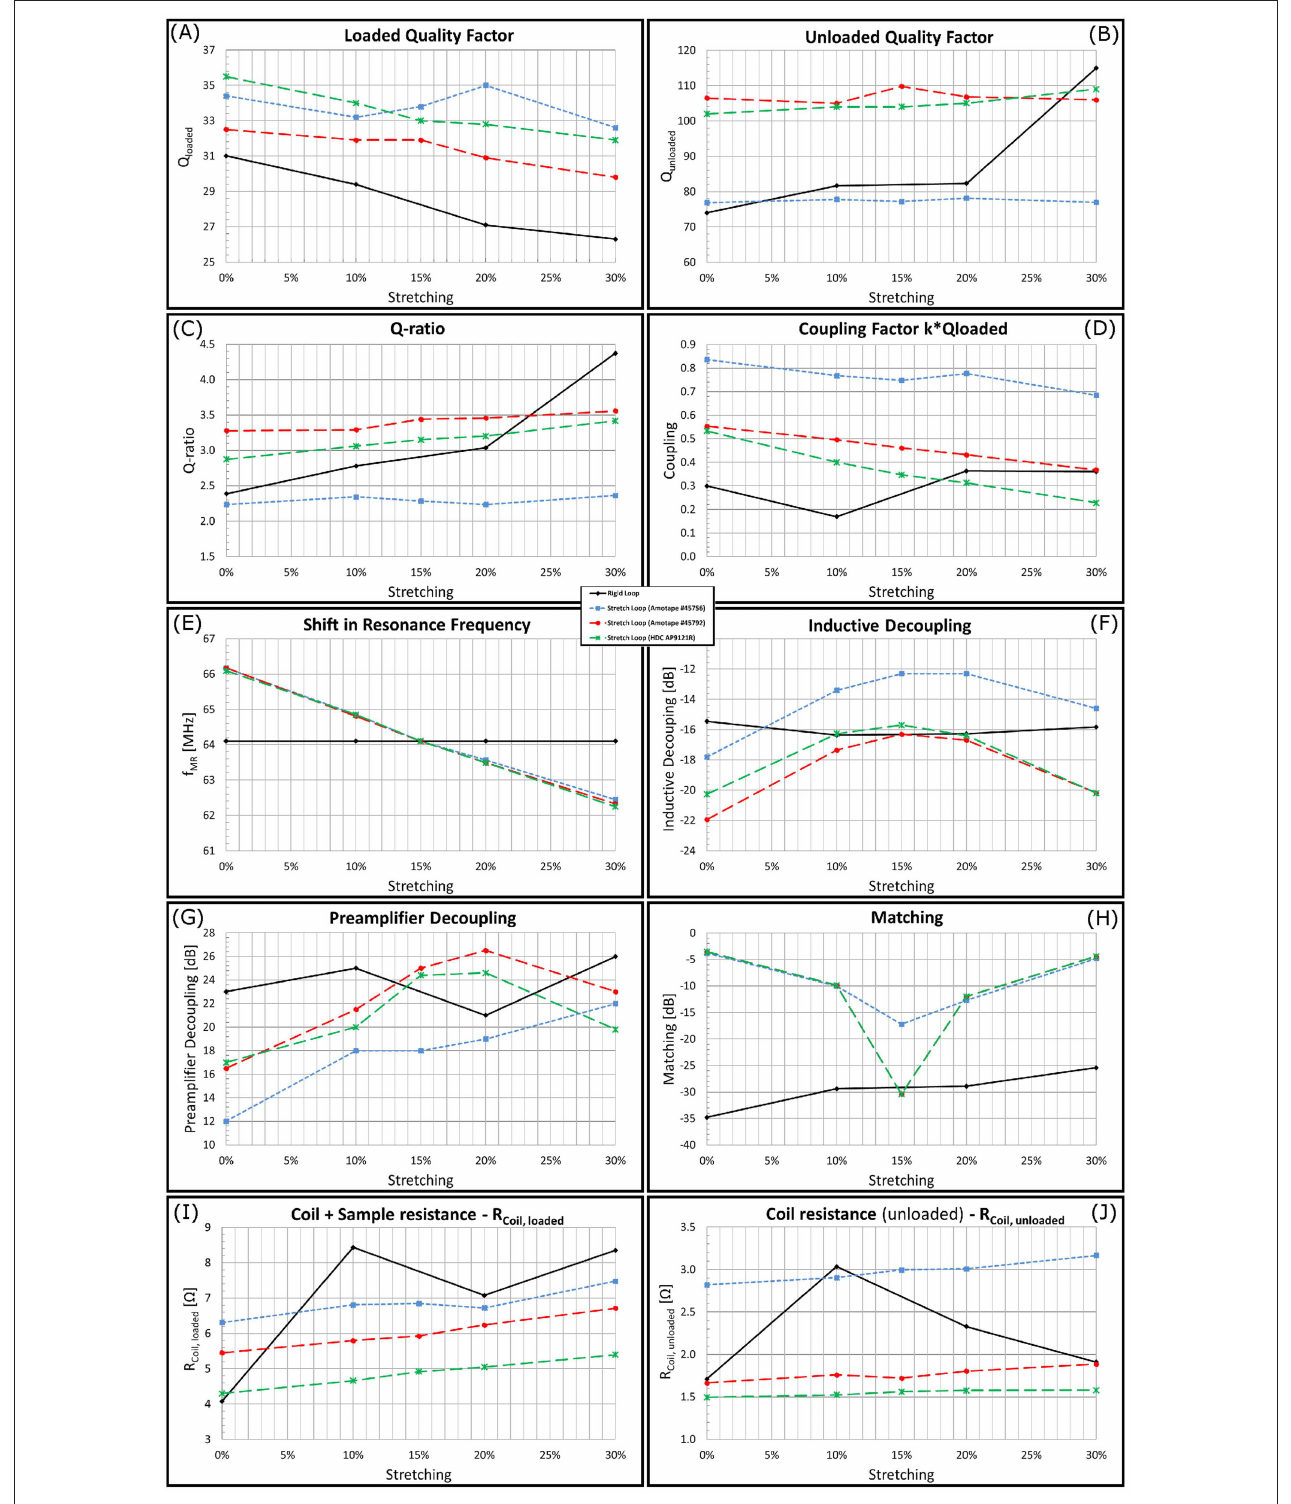
FIGURE 5 | Properties of all tested materials while mounted on the test frame, measured in the laboratory.